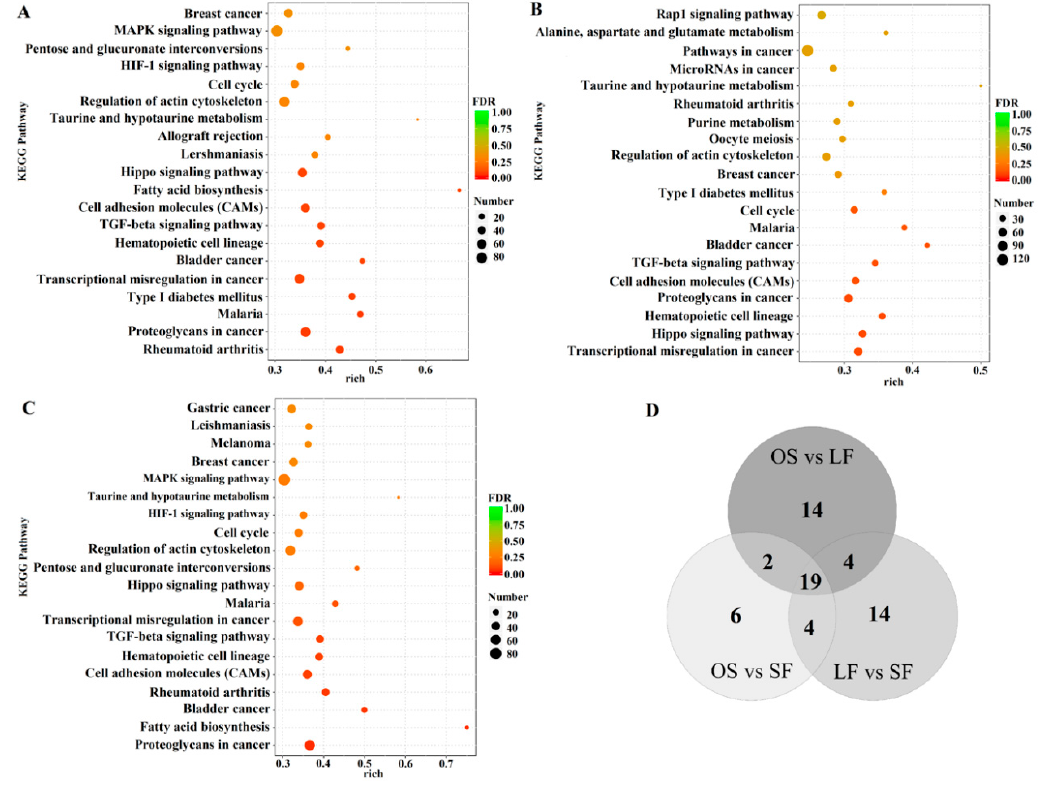
Figure 6. Top 20 significantly enriched KEGG pathways ( A ) in OS vs. LF, ( B ) in OS vs. SF, and ( C ) in LF vs. SF. ( D ) Venn diagram of the KEGG pathways in OS vs. LF, OS vs. SF, and LF vs. SF.